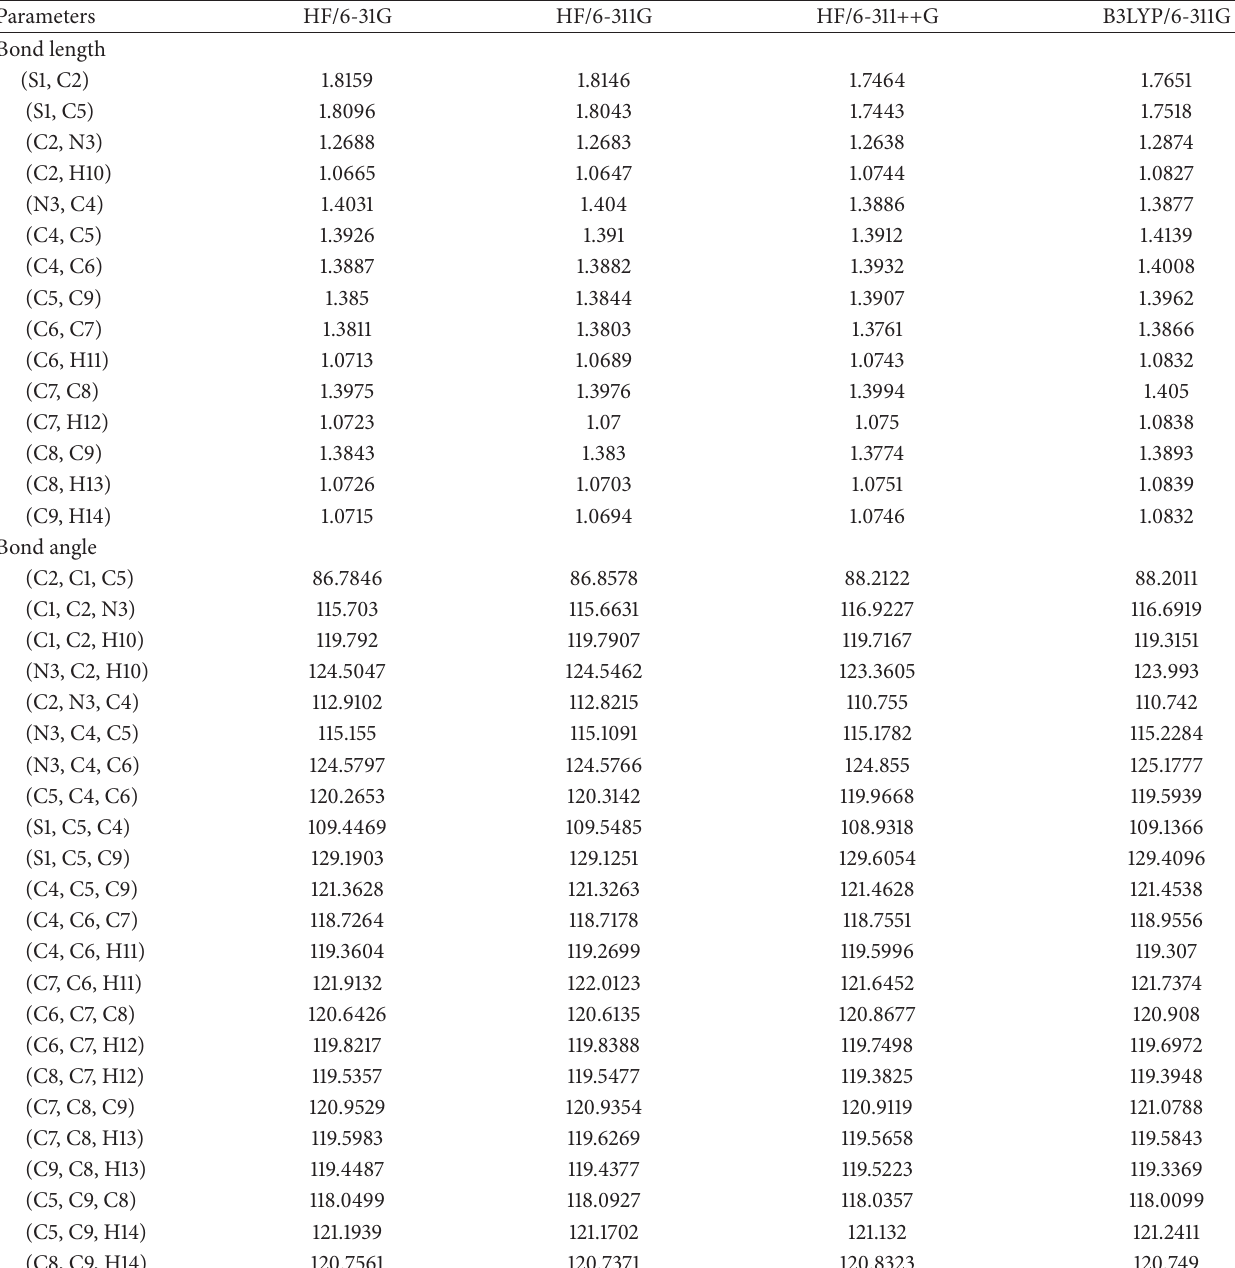
Table 1: Optimized some geometrical parameters of benzothiazole, bond length (˚A), and bond angles ( ∘ ).